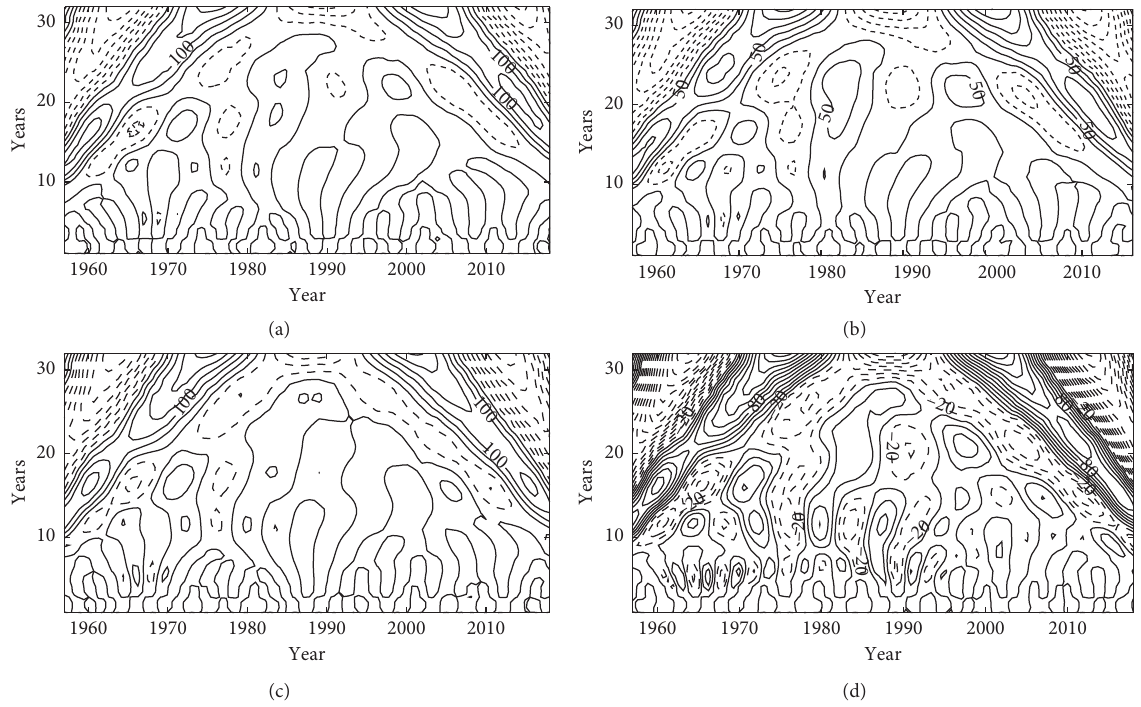
Figure 12: Wavelet analysis of each region at annual scale: (a) NX; (b) NYR; (c) CAZ; (d) SMA.